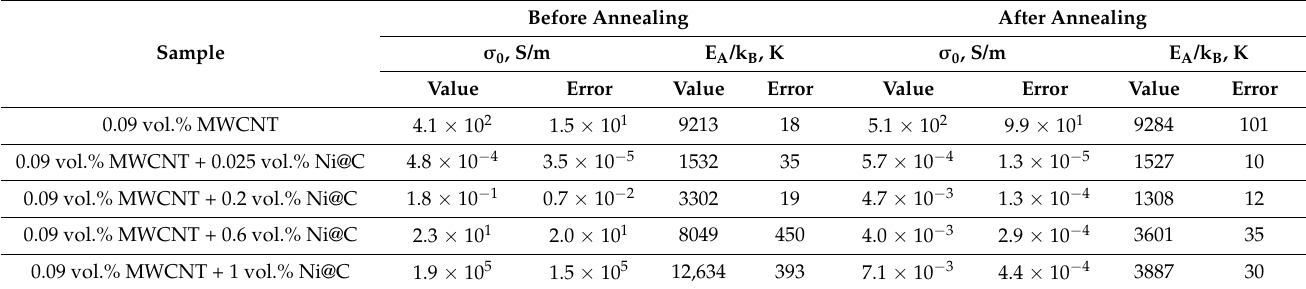
Table 2. Parameters of the Arrhenius law fit for hybrid Ni@C/MWCNTs/epoxy composites.